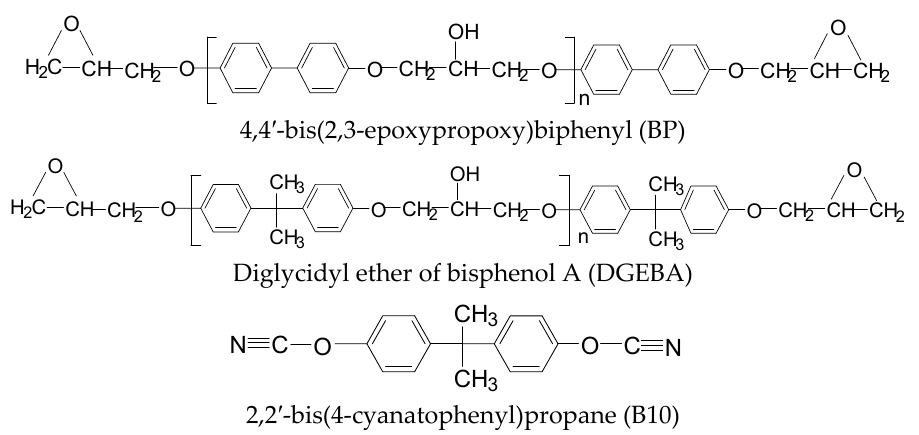
Figure 1. The chemical structures of epoxy resins (BP and DGEBA) and the curing agent (B10).